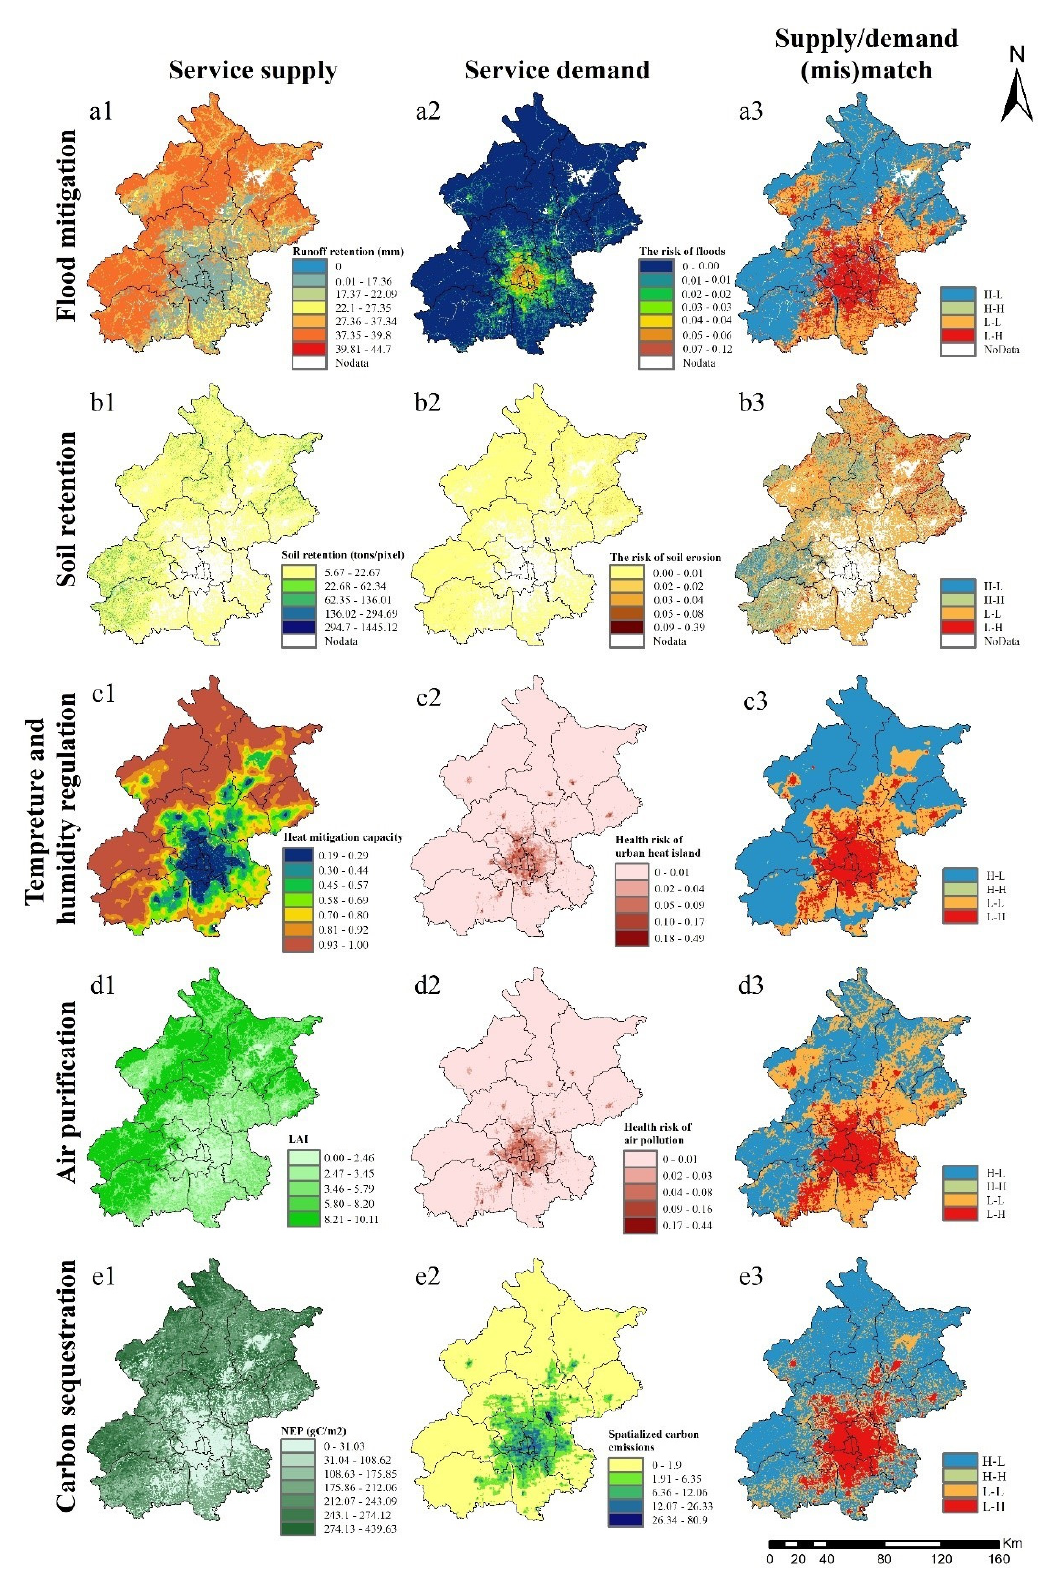
Figure 3. Supply/demand evaluation and the matching results of supply–demand relationship.